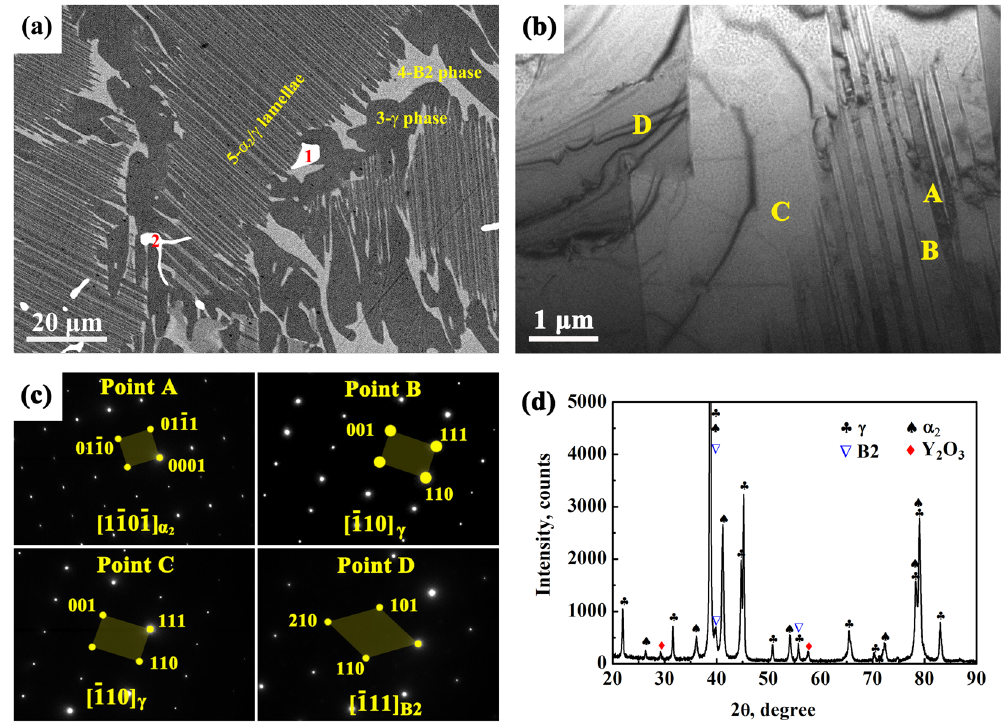
Figure 1. Microstructures of as-cast TiAlNbCr alloy. ( a ) SEM back-scattered electron micrograph showing gray α 2 -Ti 3 Al and dark γ -TiAl lamellae, white B2-phase, and bright white Y 2 O 3 particles, ( b ) TEM bright field image along with ( c ) the corresponding selected area diffraction (SAD) patterns of points A-D, where A represents α 2 -Ti 3 Al lamella, B corresponds to γ -TiAl lamella, C indicates γ -TiAl, and D stands for B2, and ( d ) XRD pattern further confirming the presence of α 2 -Ti 3 Al, γ -TiAl, B2-phase and Y 2 O 3 particles.